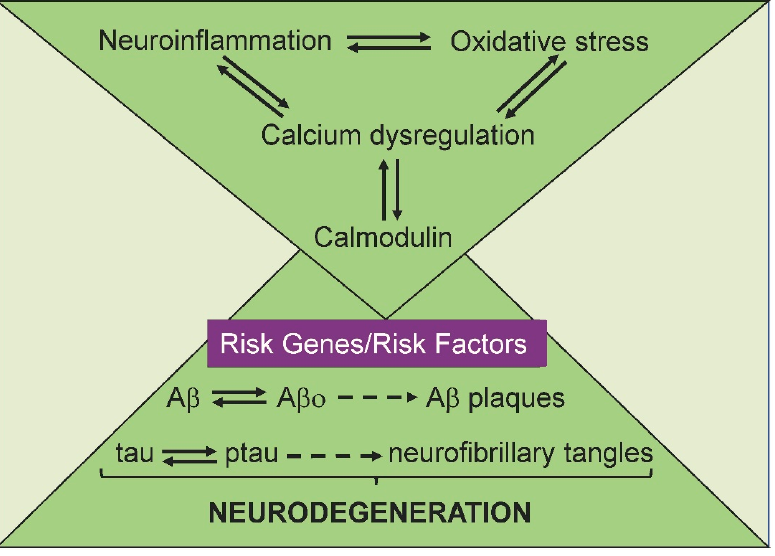
Figure 1. Some of the key events in onset and progression Alzheimer’s disease (AD). The intercon- nected early events of neuroinflammation, oxidative stress and calcium dysregulation lead to the activation of calmodulin. Together these events, and likely others, can interact with AD risk genes and risk factors leading to the formation of amyloid beta plaques and neurofibrillary tangles the classic hallmarks believed to underlie the resulting neurodegeneration that characterizes the dis- ease. A β , amyloid beta; A β o, amyloid beta oligomers; ptau, phosphorylated tau.